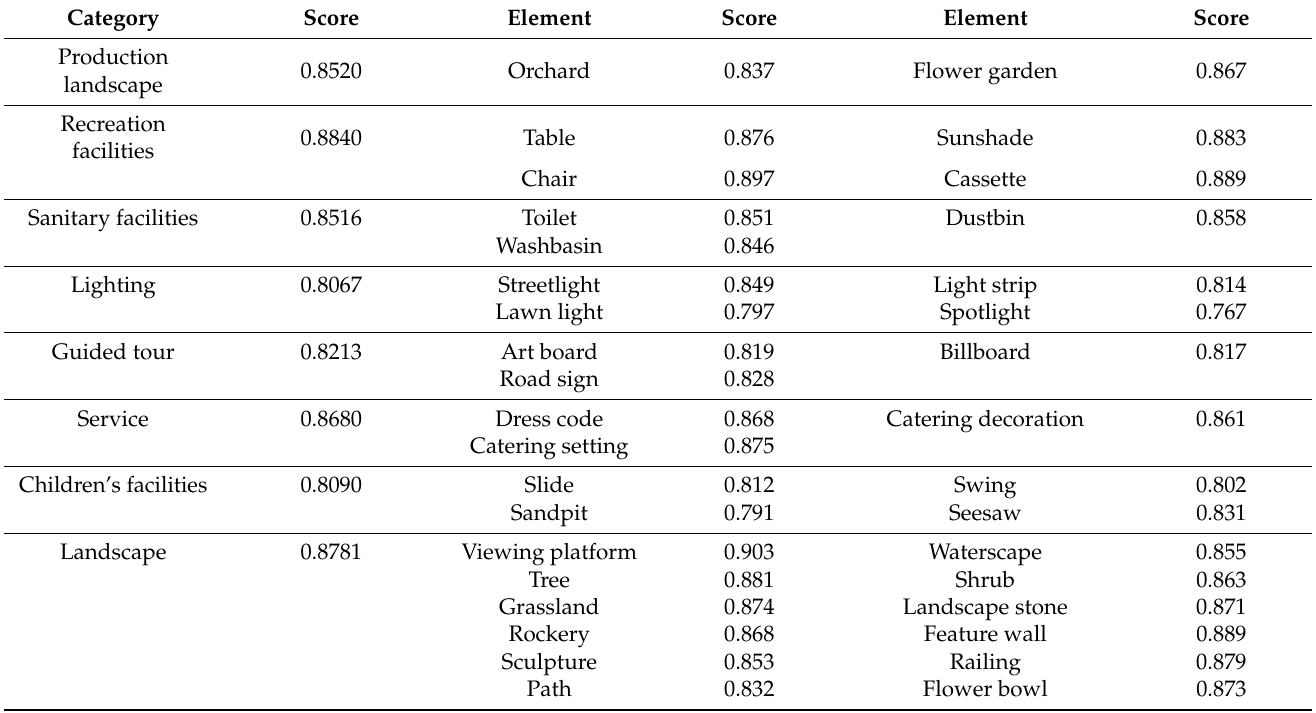
Table 4. Landscape categories and elements preference of elder dining